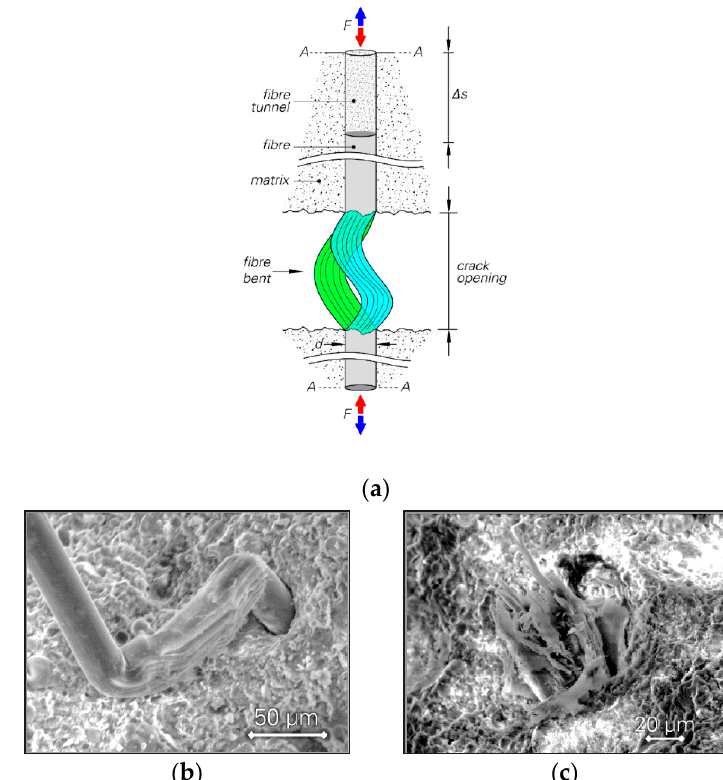
Figure 11. ( a ) Fibre bent due to large crack width under alternating tension–compression loading; scanning electron microscope (SEM) images reveal ( b ) the form of damage for C100-NC-2000-05 and ( c ) ruptured section of the fibre for C100-HC-1000-09.